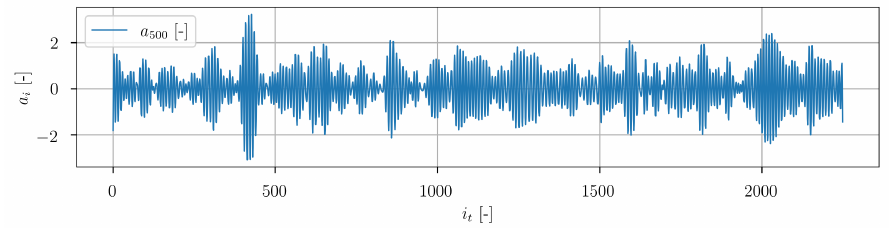
Figure 22. Temporal POD coefficients of mode 1, 5 and 15 over the snapshot index.